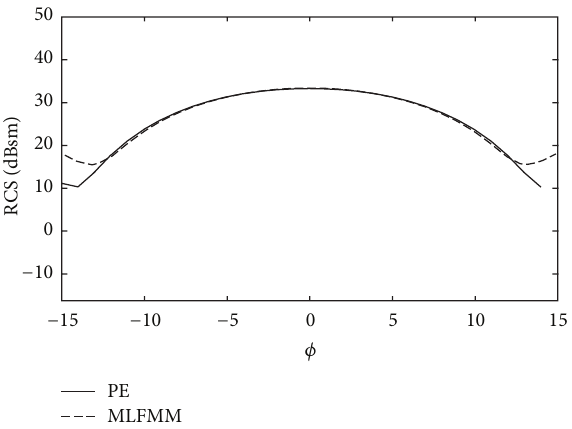
Figure 2: RCS of a PEC cylinder calculated by PE and MLFMA.